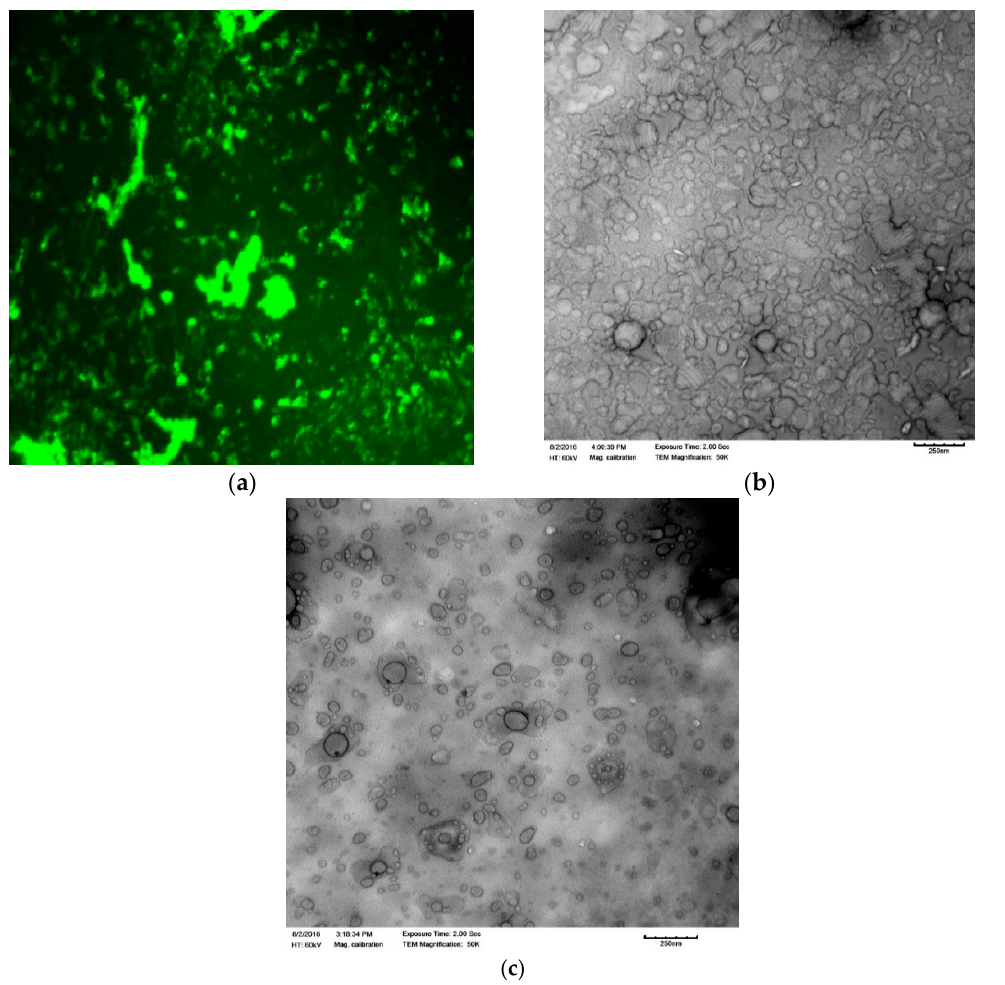
Figure 2. Fluorescence microscopy analysis of the presence of the fluorescein isothiocyanate (FITC)-labeled peptide RF-482 (green) confirms association with liposomes (40× magnification) ( a ). Transmission electron microscopy analysis. Comparison between the empty liposomes ( c ) and the RF-482 peptide-loaded liposomes ( b ).